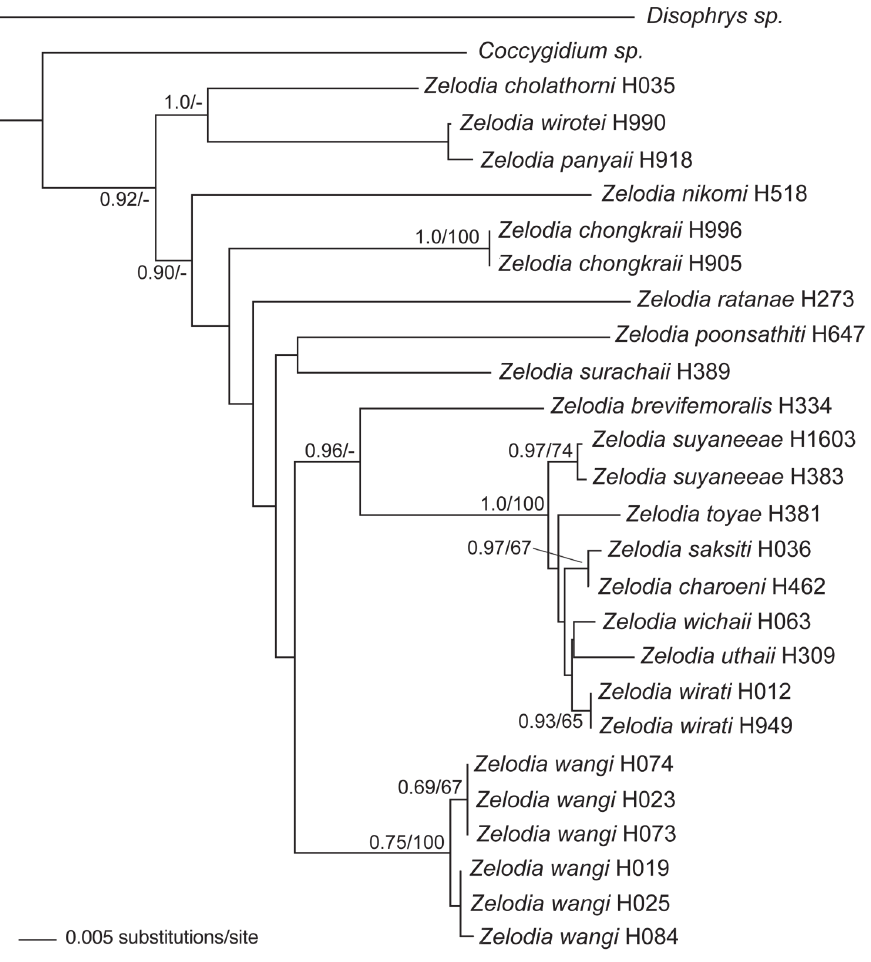
Figure 2. NJ phylogram of the COI barcode region for 17 of the 21 Zelodia species treated here. Wherever Bayesian and parsimony analyses agreed with the NJ tree branch support values are included in the figure i.e., Bayesian posterior probabilities / parsimony bootstrap (bootstrap values less than 60 are not